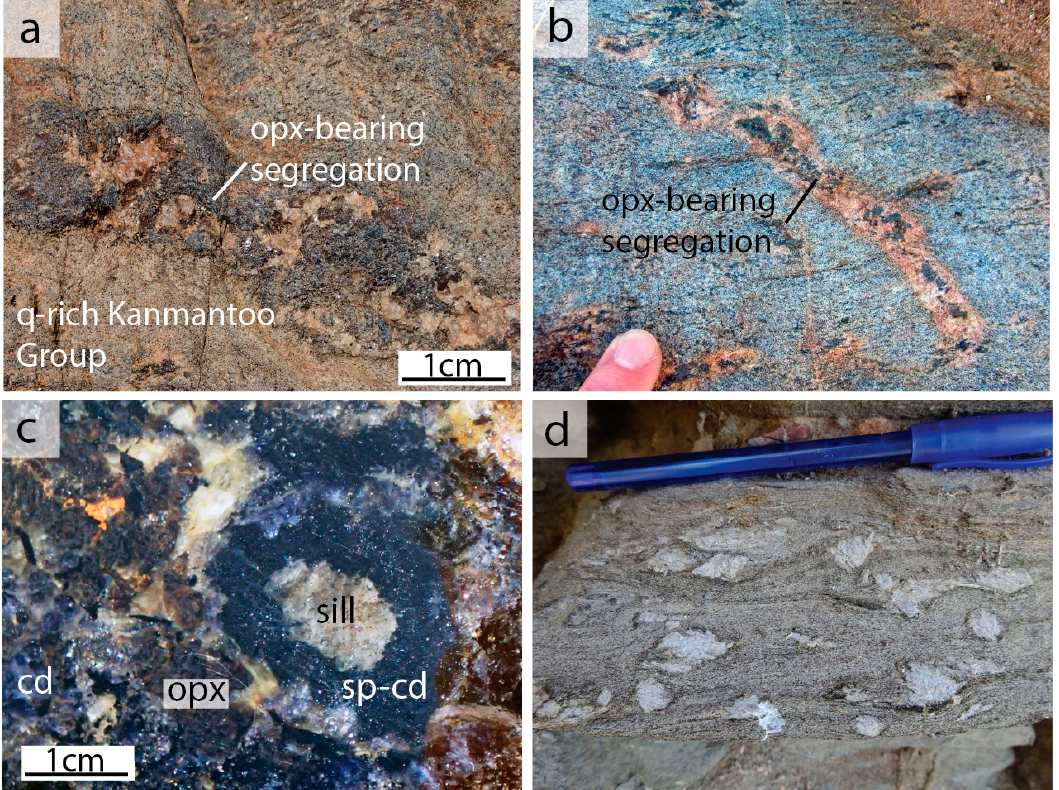
Figure 2. ( a ) Mg-rich layer dominated by cordierite–biotite–orthopyroxene–plagioclase; ( b ) Thin, discontinuous orthopyroxene-bearing domain; ( c ) Rock sample of the thin layer that was sampled showing cordierite–spinel symplectites, amongst orthopyroxene and plagioclase; ( d ) Andalusite porphyroblasts enclosed within metapelite from a lower grade area of the Delamerian (54K 0316690 E, 6122806 S, datum